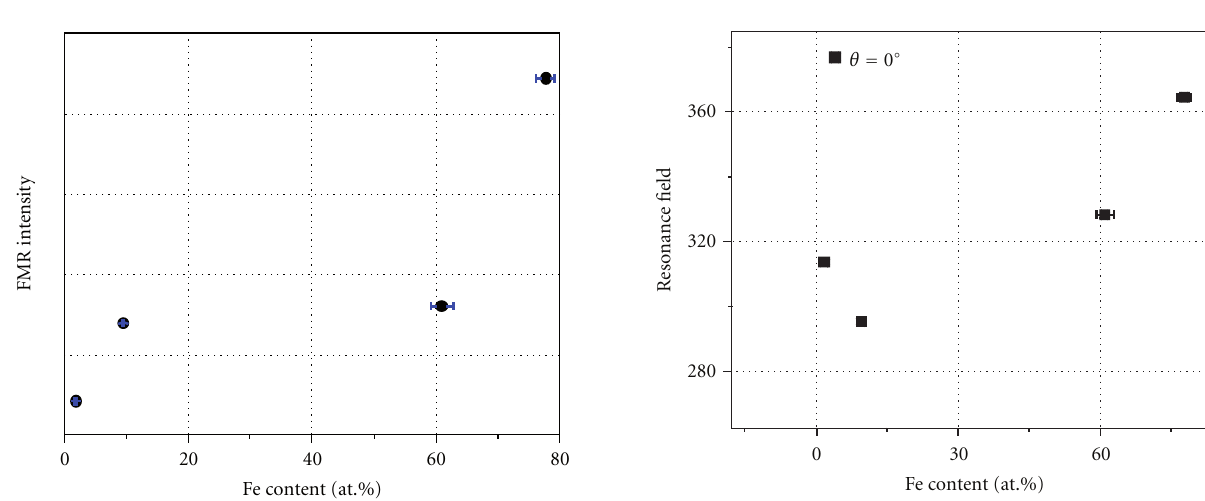
F 4: Resonance �eld plotted against Fe content. e plot suggests a higher resonance magnetic �eld as Fe content rises up as